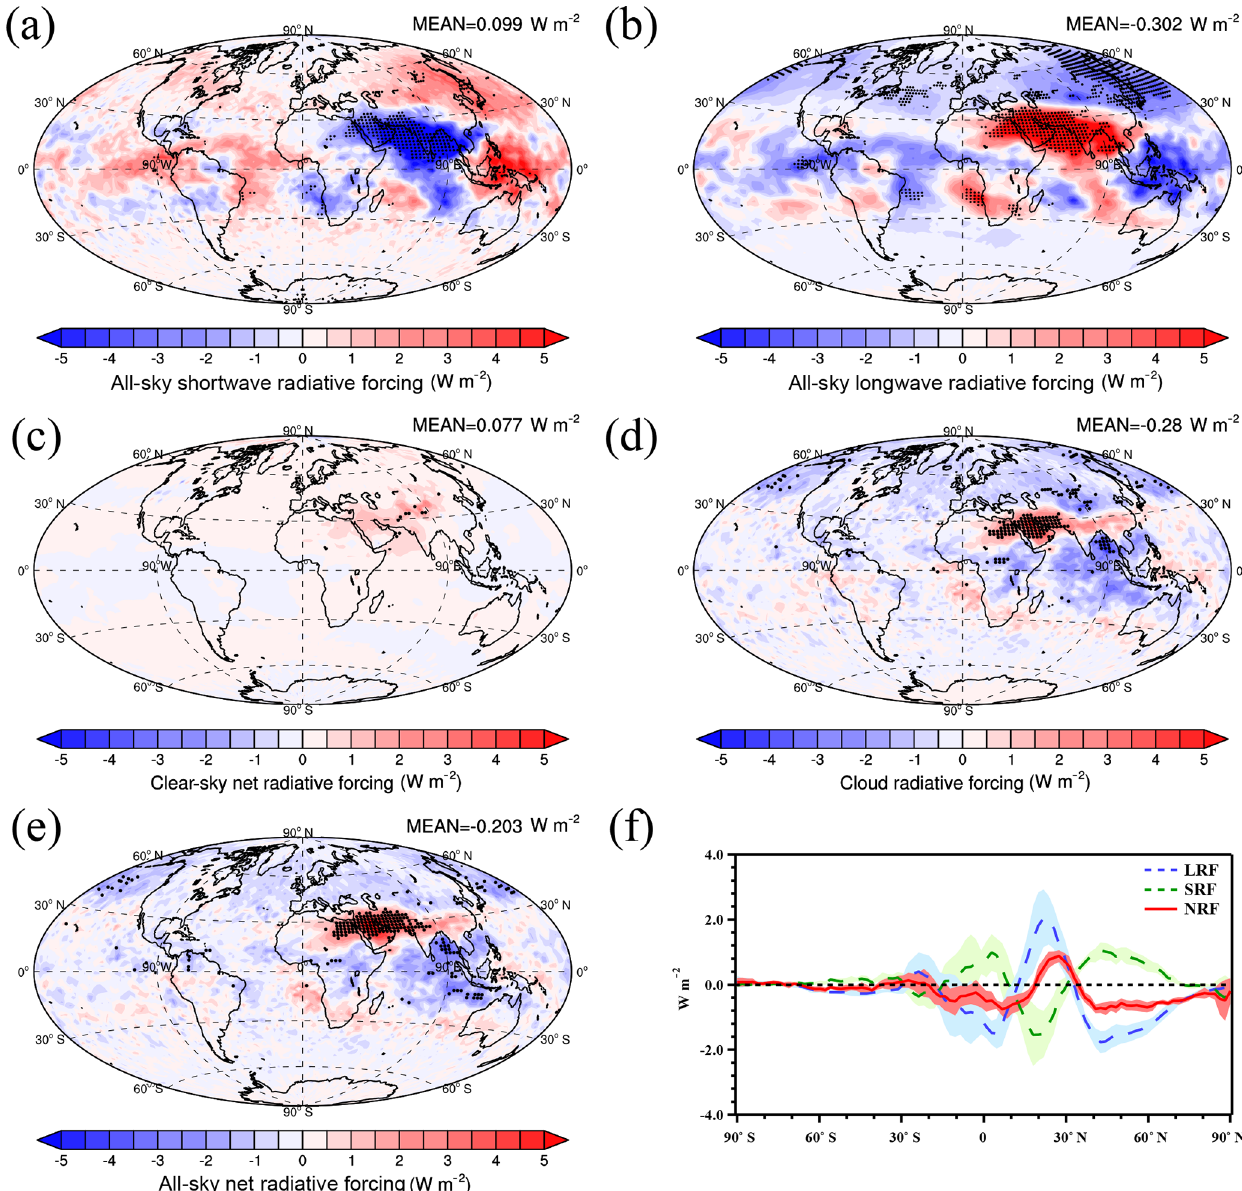
Figure 9. As in Fig. 7 but for the difference between the PD_Base and PI_ALL cases. Differences significant at the 90% level according to a Student’s t test are depicted by points. The shading in (f) represents 1 standard deviation of the interannual variation over 6